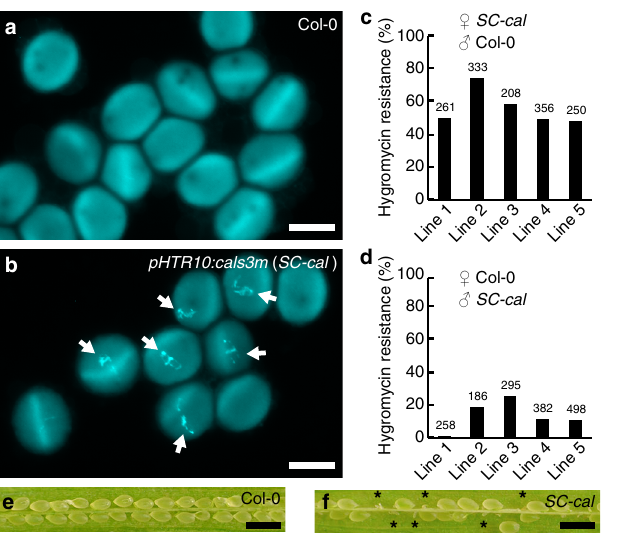
Fig. 1 Partial male sterility induced by callose accumulation in sperm cells. a , b Aniline blue staining of mature pollen from wild-type Col-0 plants (Col-0, a ) or hemizygous pHTR10:cals3m plants ( SC-cal , b ). Arrows in ( b ) indicate callose deposition in sperm cells. Images are representative of three ( a ) or six ( b ) observations. c , d Transmission of SC-cal transgene from female gametophytes ( c ) or male gametophytes ( d ) analyzed by hygromycin resistance of T 1 plants obtained following reciprocal crosses between the SC-cal transgenic lines and wild-type Col-0 plants. Line 2 shows higher hygromycin resistance in ( c ) possibly due to the multiple insertions of the SC-cal . Numbers above the bars indicate seeds analyzed. e , f Developing seeds in Col-0 ( e ) or an SC-cal transgenic line ( f ). Images in ( e ) or ( f ) show representative of two pistils analyzed. Asterisks in ( f ) represent undeveloped seeds. Scale bars: 20 μ m in ( b , c ); 1 mm in ( e , f nuclear staining dye SYBR Green I. Then, pollen tubes that emerged from the cut styles were analyzed using confocal laser scanning microscopy (Fig. 3c, e). In tdTomato-negative pollen tubes ( SC-cal − RHT − ), nuclear triplets of the vegetative nucleus